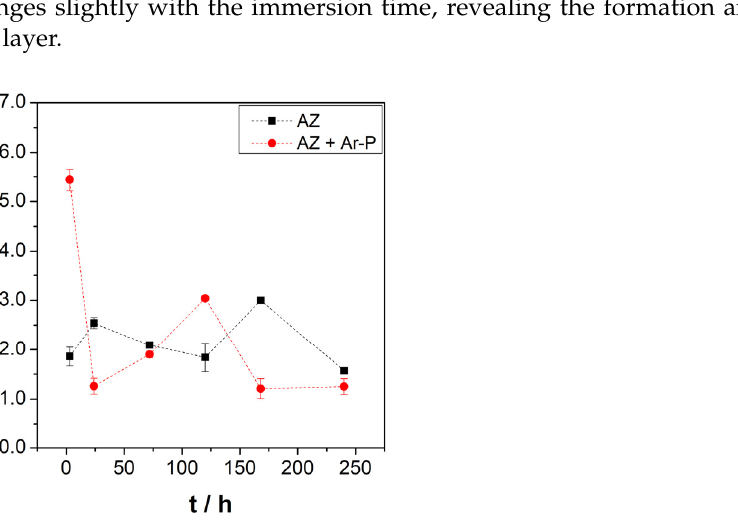
Figure 8. Evolution of the layer thickness ( δ ox ) for the differently pretreated AZ31 alloy immersed in 0.1 M of Na 2 SO 4 .